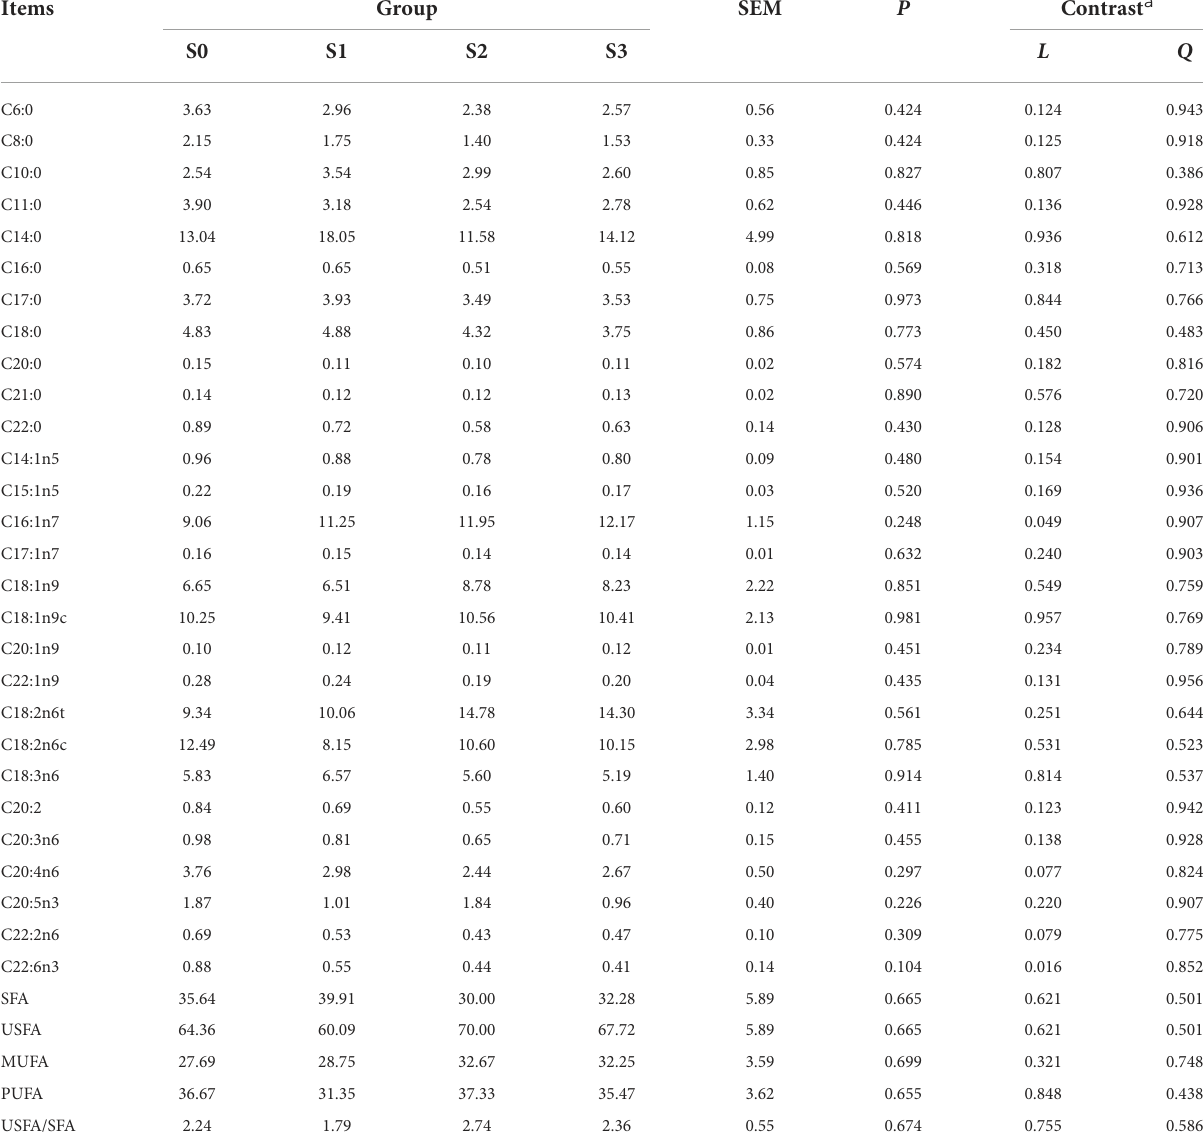
TABLE 5 Fatty acids profile in the thigh muscle of broilers